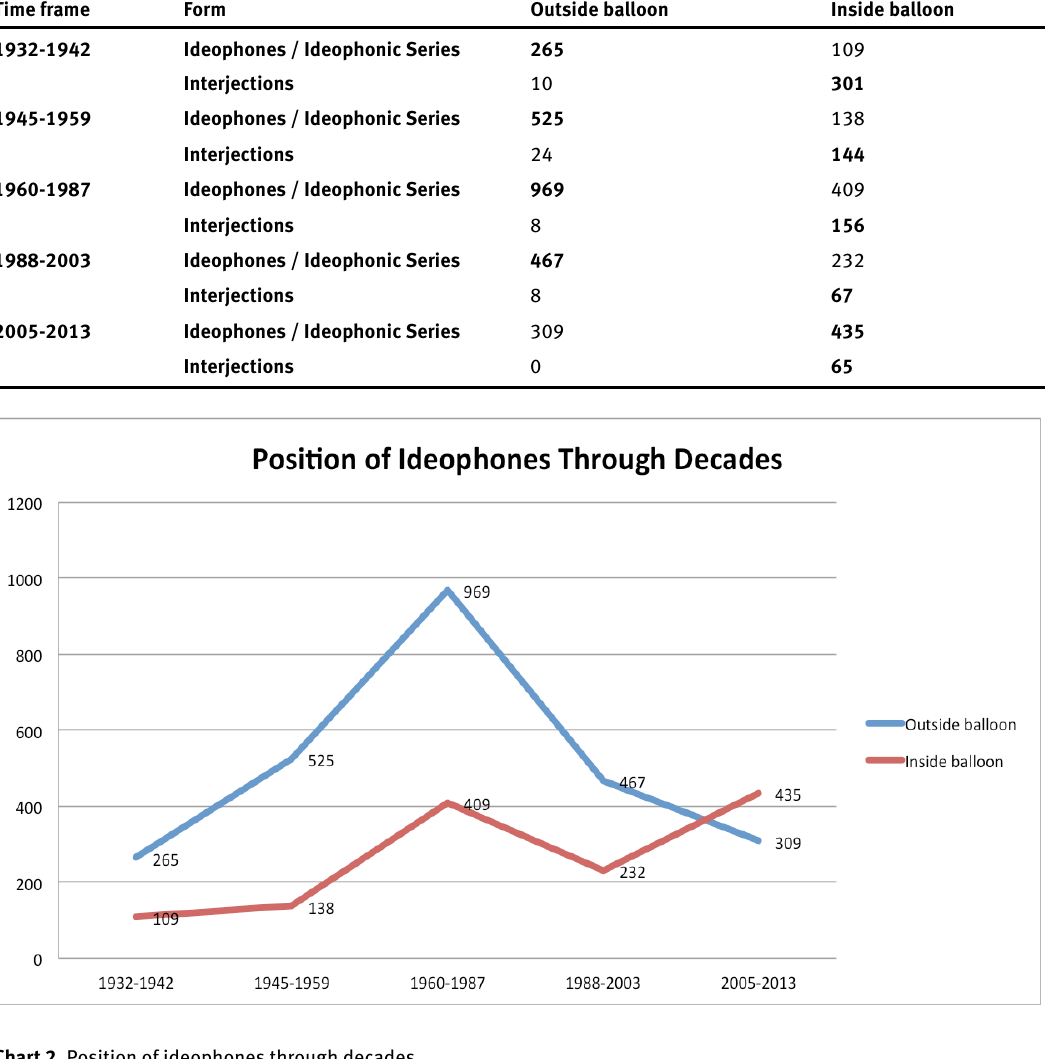
Table 5. Position of ideophones and interjections through the decades. Cf. chart 2 for visual